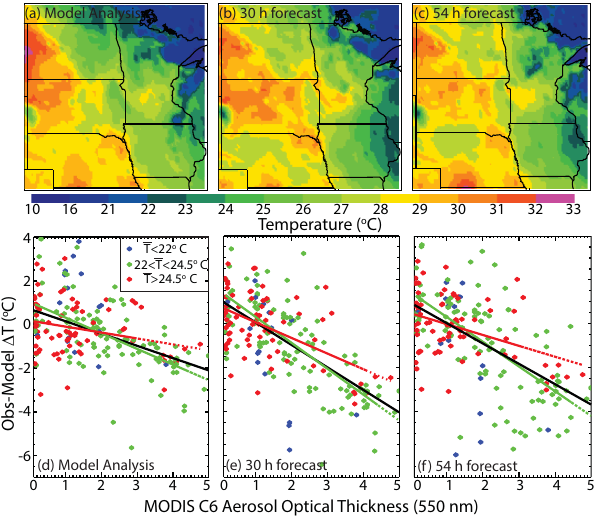
Figure 8. (a–c) 0, 30, and 54h forecasts of 2m air temperatures for the study region as shown in Fig. 3a at 18:00UTC, 29 June 2015 from ECMWF model runs. (d–f) . The differences between surface observations (using ground stations as shown in Fig. 3c) and ECMWF-modeled 2m temperatures (at 18:00UTC, 29 June 2015) as a function of Collection 6 Terra MODIS DT τ 550 . Data pairs are colored based on the observed monthly mean surface tempera- tures at 18:00UTC as shown in Fig. 3g. Data pairs for regions with monthly mean temperatures of <22 ◦ C, between 22 and 24.5 ◦ C and >24.5 ◦ C are colored in blue, green, and red respectively. Red dashed lines are the linear fit lines to the data pairs with red col- ors, and green dashed lines are the linear fit lines for data pairs with green